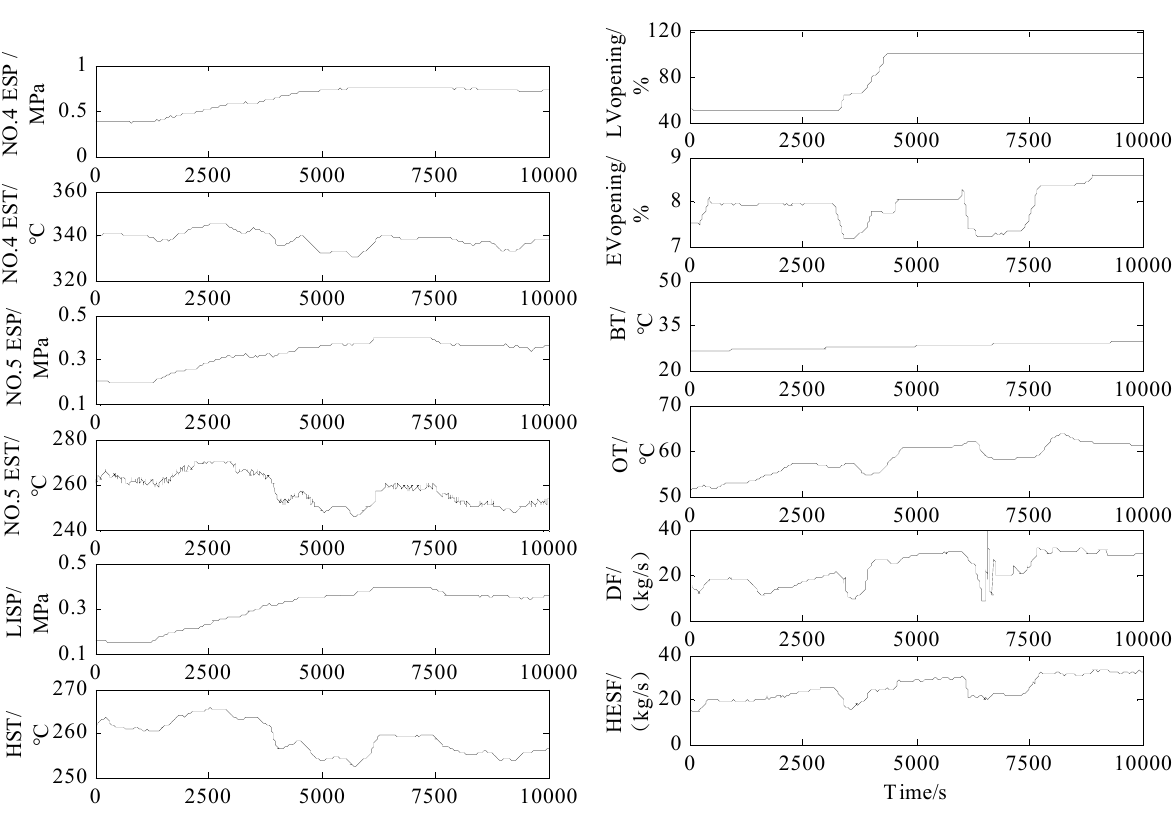
Figure 6. Dynamic response under large-scale load variation conditions.